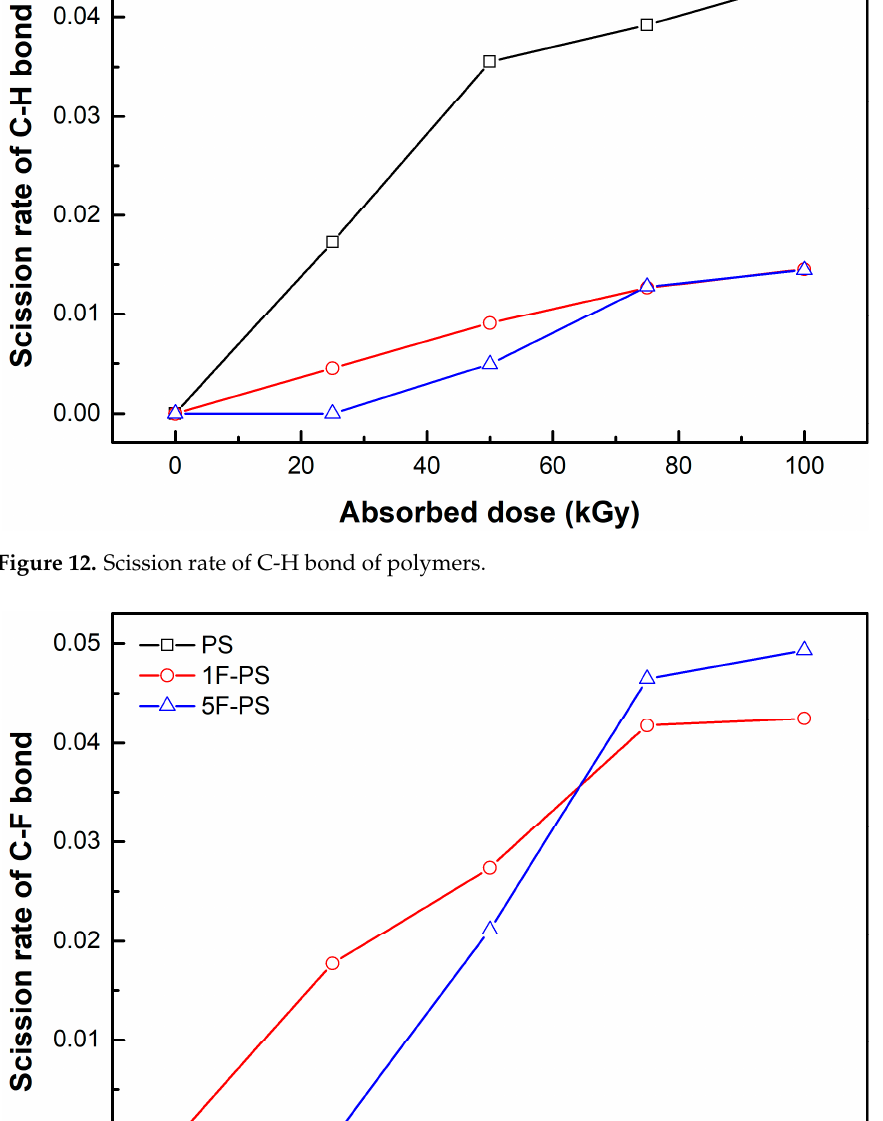
Figure 13. Scission rate of C-F bond of polymers. The scission rate of the C-C bond was the highest in the polystyrene. The value of the scission rate was increased sharply in the region of 25 to 50 kGy for polystyrene and 1F-PS and 50 to 75 kGy for 5F-PS. These results were similar with the maximum dissociation rate region, which were 3 (#/kGy) from 25 to 50 kGy at the polystyrene, 1.96 (#/kGy) from 25 to 50 kGy at the 1F-PS, and 2.84 (#/kGy) from 50 to 75 kGy at the 5F-PS. This relation was also investigated in the gel permeation chromatography results. The difference of Mn was the highest in the region of 25 to 50 kGy for polystyrene and